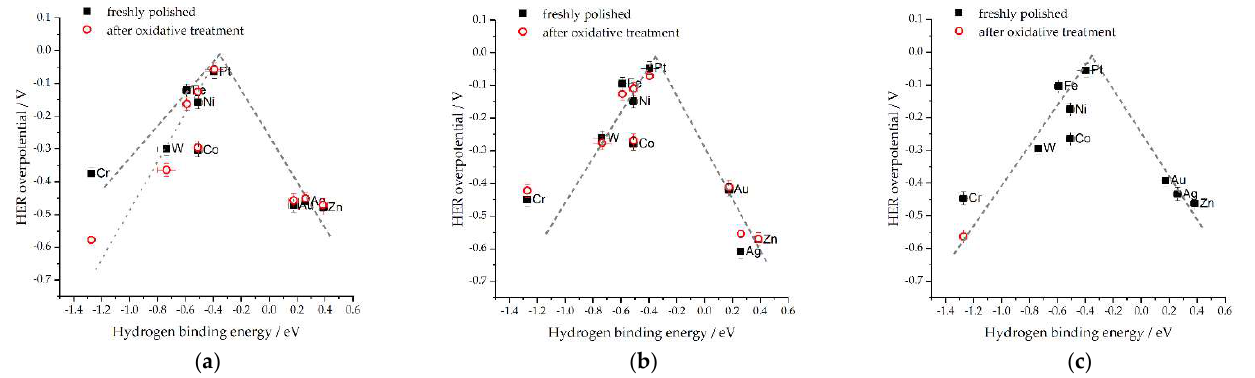
Figure 3. The HER volcanoes in alkaline media: ( a ) 0.1 mol dm −3 KOH; ( b ) 0.1 mol dm −3 LiOH; ( c ) 1 mol dm −3 KOH. Squares represent freshly polished electrodes, while circles are for the electrodes after oxidative treatment. In the case of 0.1 mol dm −3 KOH, one can draw two strongly binding branches of the HER volcano, depending on the presence of oxide on the surface.